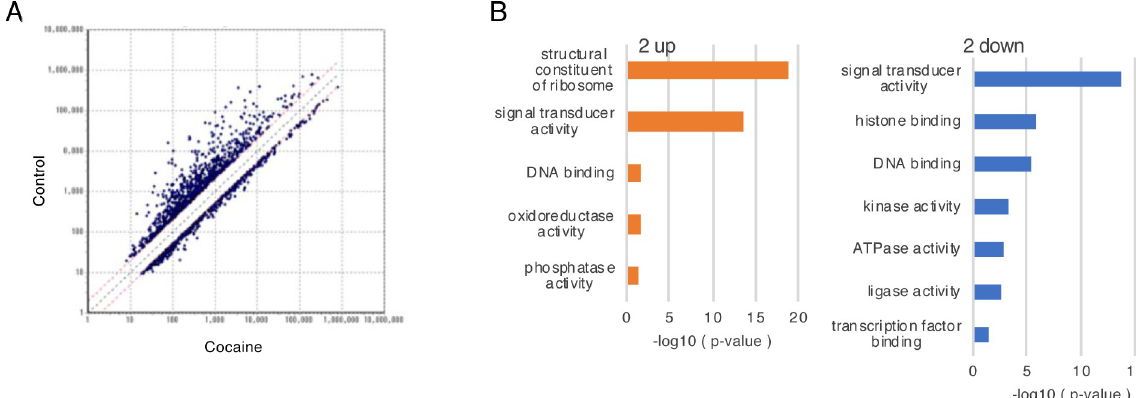
Fig 3. Transcriptional profile of spleen from rats repeatedly administered cocaine (day 7). Total RNAs from spleen (day 7) were subjected to DNA microarray and subsequent gene ontology (GO) analysis. (A) A scatter plot analysis of transcripts that showed greater than 2-fold responses to cocaine. The data below the lower dotted line indicate a greater than 2-fold increase caused by cocaine. The data above the upper dotted line indicate a greater than 2-fold decrease caused by cocaine. (B) Molecular function categories (Gene Ontology terms, GO) identified by Microarray Data Analysis Tool as being affected by cocaine in the spleen. P-values were calculated by comparison to the control group.